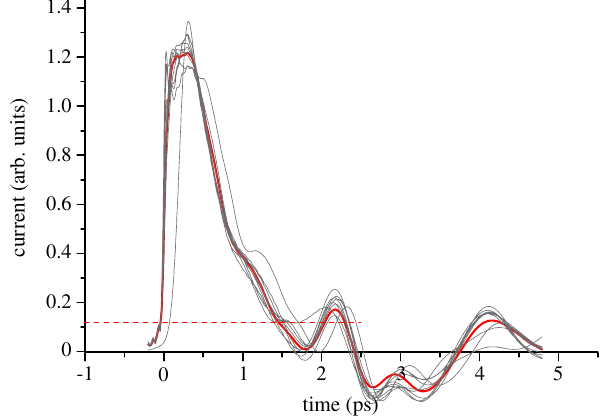
FIG. 12. A set of bunch profiles reconstructed from data taken on June 25, 2012.